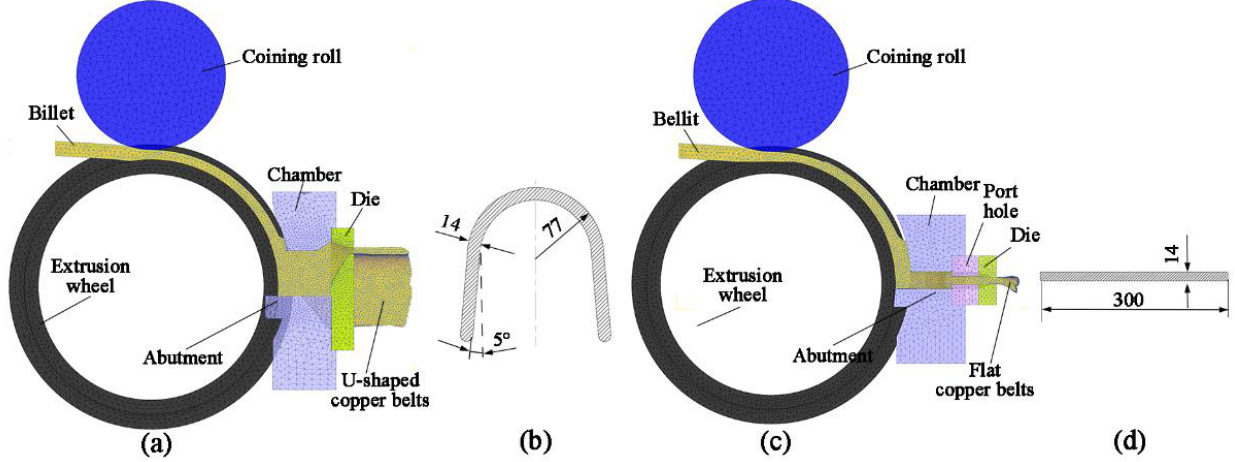
Figure 2. Finite element model and cross-sectional dimensions of copper strips: ( a , b ) U-Shaped strips; ( c , d ) Flat strips.